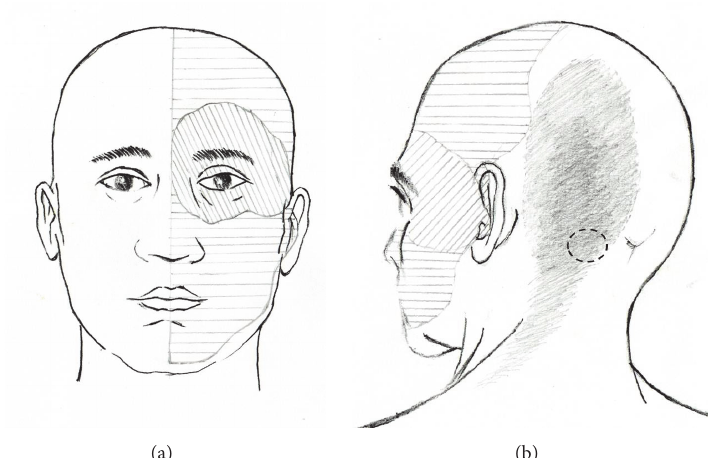
Figure 1: A schematic diagram demonstrating the distribution of occipital neuralgia and hemifacial sensory change with facial pain. (a) The grey areas over the left occipital area indicate the distribution of stabbing pain of occipital neuralgia. A tender point was present along the course of the greater occipital nerve. (b) The obliquely hatched area denotes regions of facial pain in addition to hypesthesia. The horizontally hatched area shows the distribution of hemifacial hypesthesia and